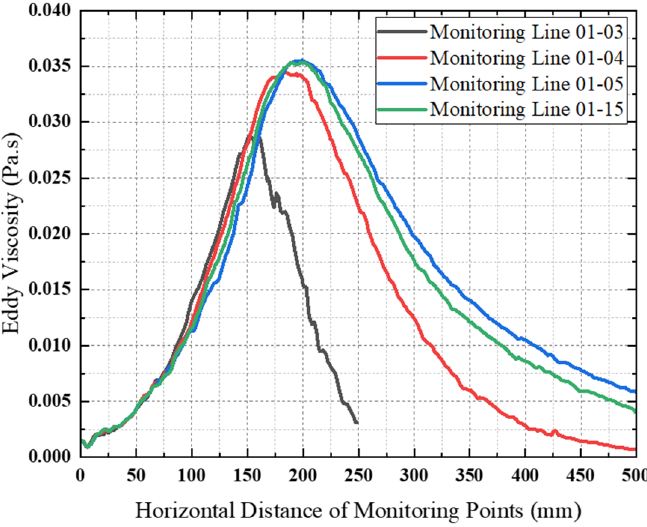
Figure 7. Line chart of the eddy viscosity of the equal-diameter nozzle flow field with a compressed air pressure of 212,782 Pa and a temperature of 303 K.